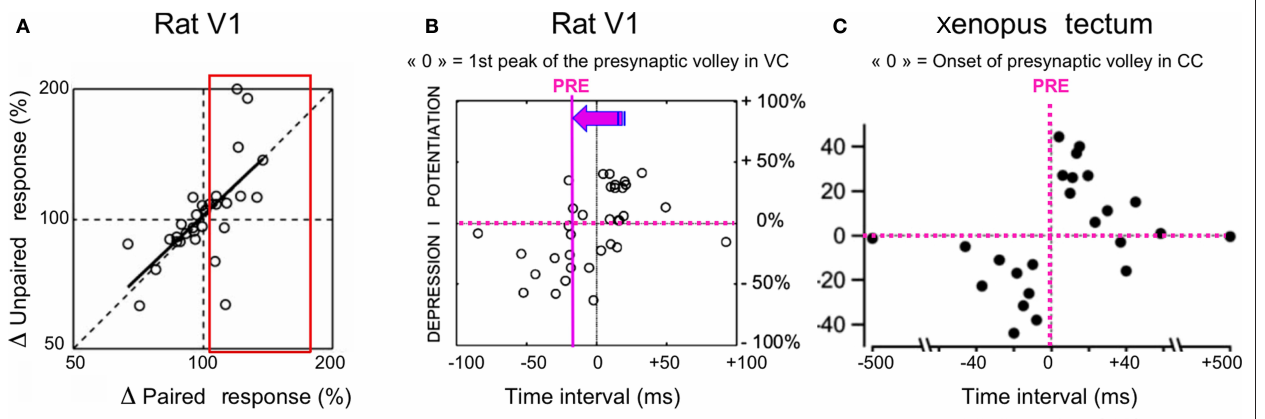
shown in (C) . “0” represents the occurrence of the peak inward current measured in voltage clamp (VC). The purple y -axis, shifted to the left, represents the most likely arrival time of the first presynaptic spike. The position difference between the two- y axes corresponds to the mean delay separating the onset from the peak input. (C) Xenopus tectum, taken from Figure 2H in Mu and Poo (2006): STDP curve induced by repetitive single-bar stimulation in the developing retino-tectal system of Xenopus. The graph is aligned on the presynaptic volley onset and shows a clear partition of spike timing-dependent depression (negative delays) and potentiation (positive delays) of tectal responses, recorded in current clamp (CC). Each point represents the result from one